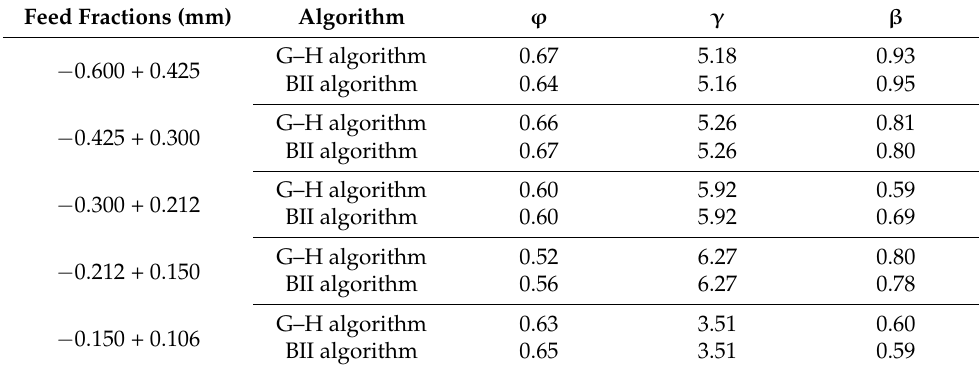
Figure 5. Austin empirical formula for magnetite wet-grinding experiment. Table 4. Breakage distribution function parameters for